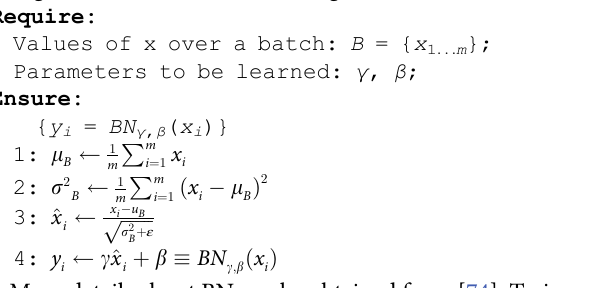
Algorithm 2 Batch Normalizing